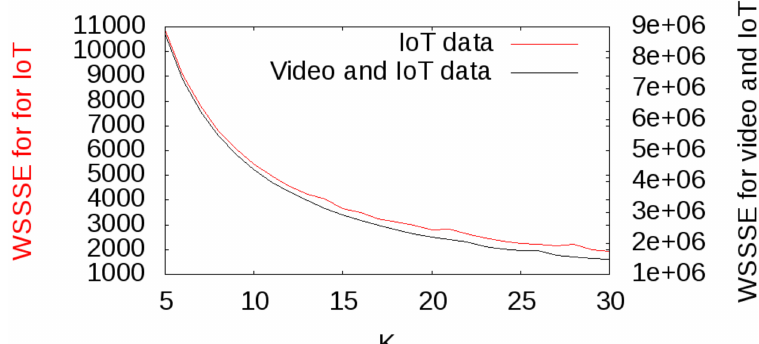
Figure 12. The k -means clustering for IoT only and video/IoT scenarios. The diagram illustrates average distances to cluster centroids with different numbers ( k ) of clusters. The left side y-columns provide values for IoT data (red curves) and the right side y-columns provide values for video/IoT data (black curves). WSSSE: Within Set Sum of Squared Errors.